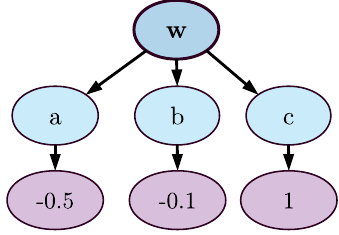
Figure 1. An algebraic decision